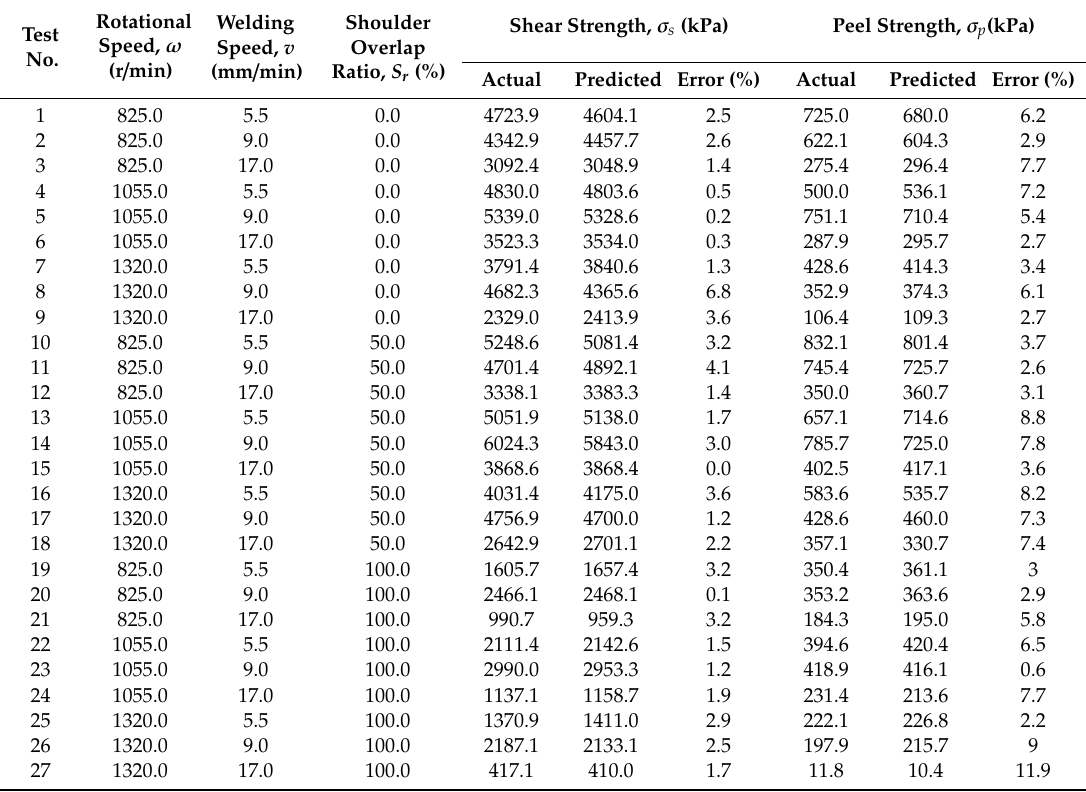
Table 4. Experimental design matrix with evaluated